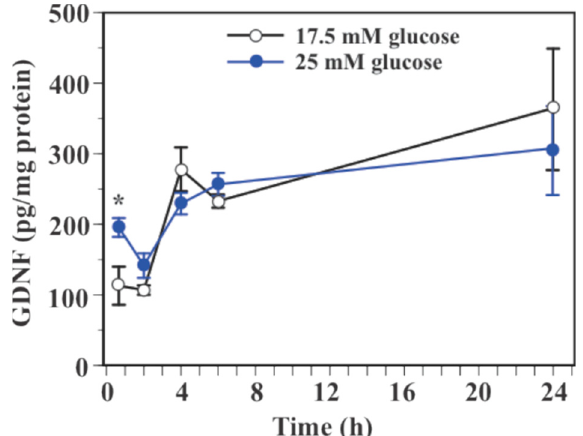
Figure 3. Effect of glucose on GDNF protein levels in microglial SIM ‐ A9 cells. Cells were incubated in a culture medium containing 17.5 mM or 25 mM glucose for 40 min, 2, 4, 6, or 24 h. Levels of GDNF protein were measured by ELISA. Data are means ± S. E. M. ( n = 6–8/group). *: p < 0.05 vs. control at the same time point by Student’s t ‐ test.